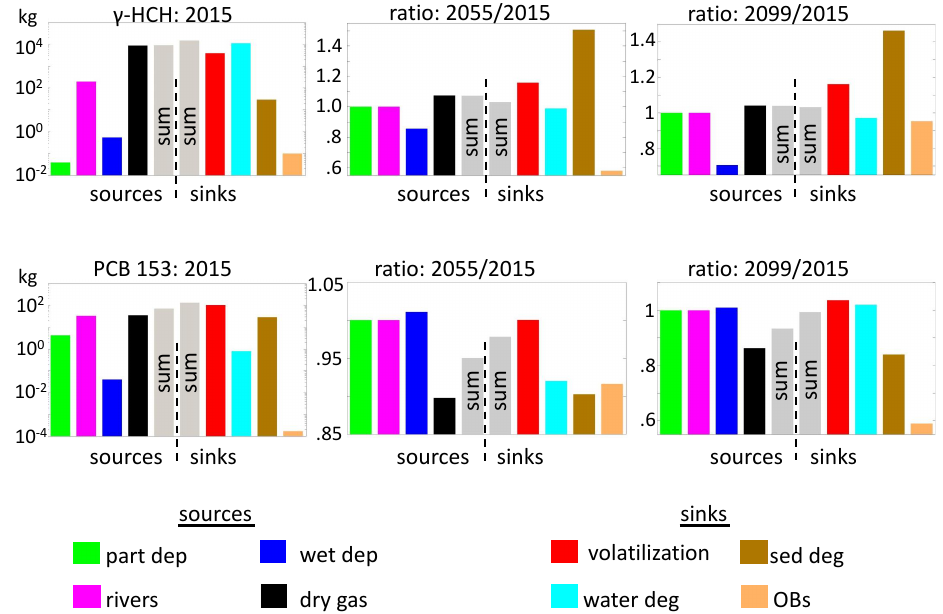
Figure 7. Total annual mass fluxes, [kg] log10 scale, of North Sea sources and sinks for 2015, left panels. Ratios of total annual mass fluxes: 2015/2055 (centre panels) and 2099/2015 (right panels). Sources are deposition with particles, input through rivers, wet deposition and gas deposition. Sinks are volatilization, degradation in water, degradation in sediment and net outward flux through the open ocean boundaries (OBs). The sums of sources and sinks are given by the grey